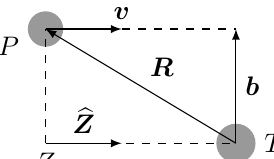
Figure 1: System of coordinates used in the eikonal approximation to describe the collision of a one-body projectile P on a structureless target T . The P - T relative coordinate R is decomposed into its longitudinal Z and transverse b components relative to the beam